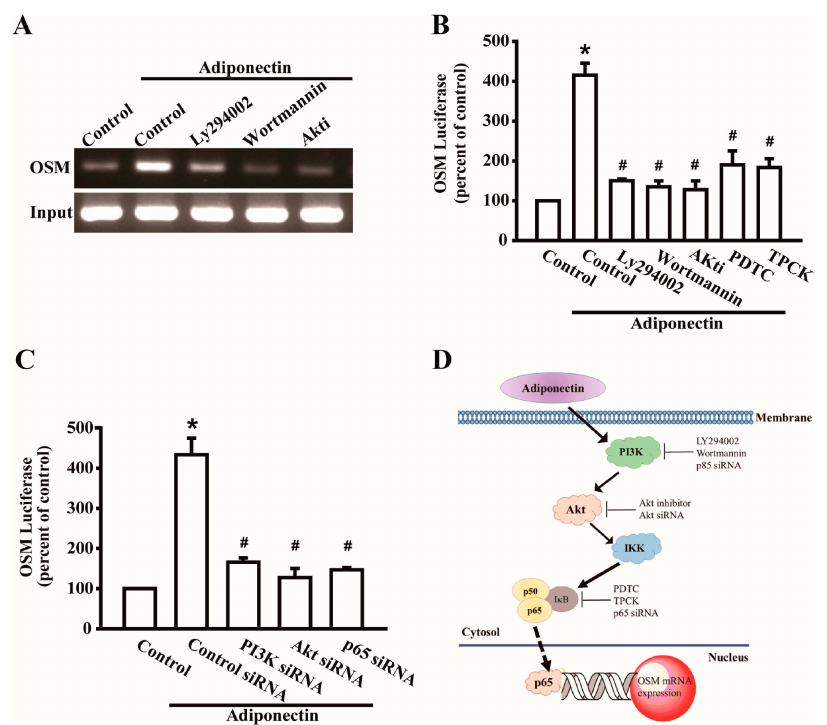
Figure 5. Adiponectin triggers p65 binding to OSM promoter. ( A ) Osteoblasts were pretreated with PI3K inhibitors, LY294002 (10 µ M) or Wortmannin (5 µ M), or Akt inhibitor (20 µ M) for 30 min stimulated with adiponectin (100 ng/mL) for 60 min, and the chromatin immunoprecipitation assay was performed ( n = 8); ( B ) Osteoblasts were pretreated with LY294002, Wortmannin, Akt inhibitor, PDTC, or TPCK for 30 min followed by treatment with adiponectin (100 ng/mL) ( n = 6); ( C ) Osteoblasts were transfected with PI3K, Akt, or p65 siRNA (0.5 nM) followed by treatment with adiponectin (100 ng/mL). OSM-luciferase activity was measured, and the results were normalized to the β -galactosidase activity ( n = 6). Results are expressed as mean ˘ S.E.M. *, p < 0.05 compared with control; # , p < 0.05 compared with adiponectin-treated group; ( D ) The schematic diagram of the signaling pathway showed adiponectin-induced OSM expression in osteoblastic cells. Solid arrow means signal transduction and dotted arrow means